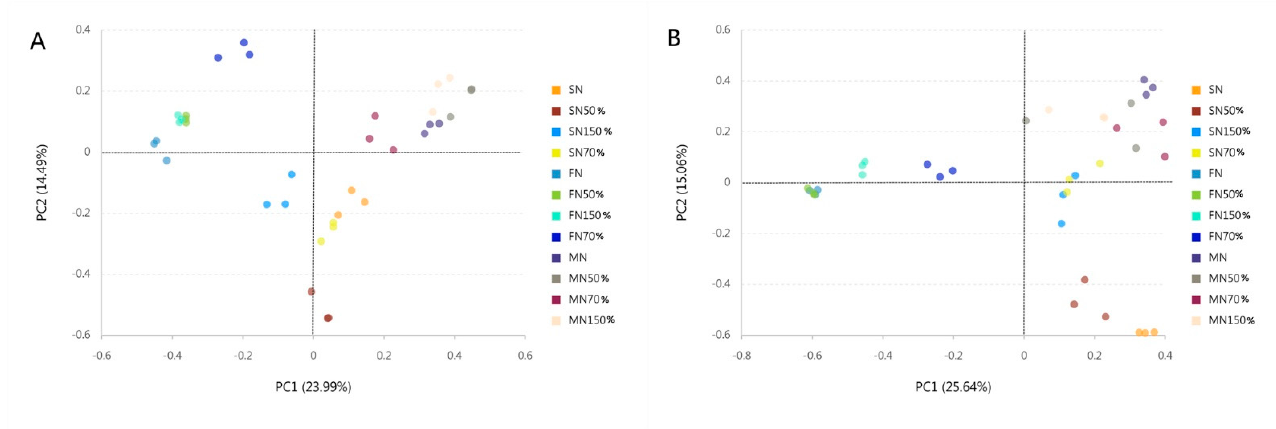
Figure 7. Principal component analysis (PCA) of all samples. ( A ): Principal component analysis of bacterial; ( B ): principal component analysis of bacterial fungi.